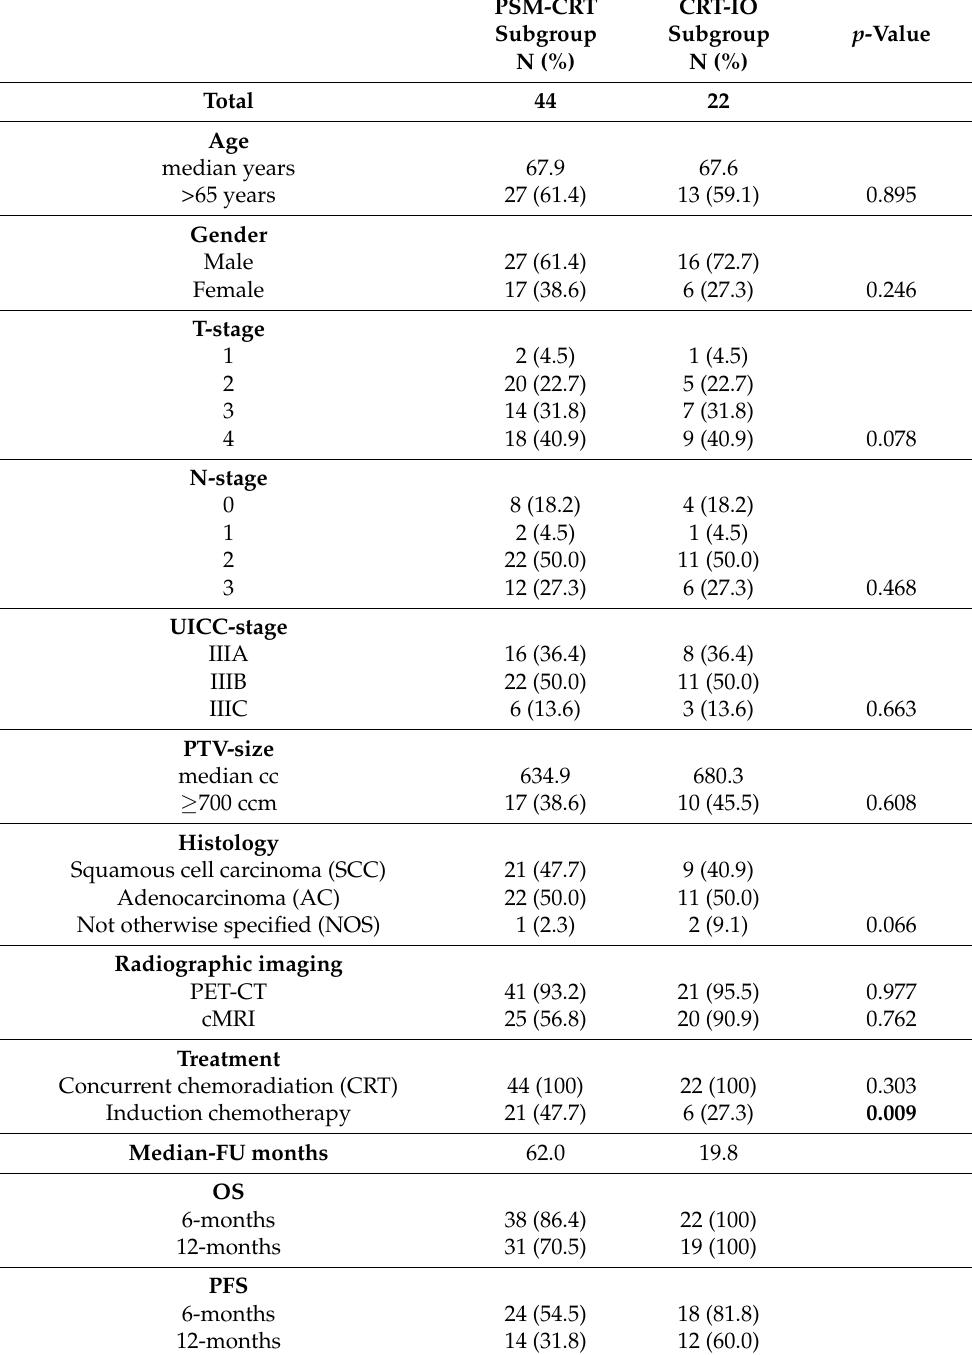
Table 3. Comparison of the CRT-IO subgroup and the PS-matched CRT